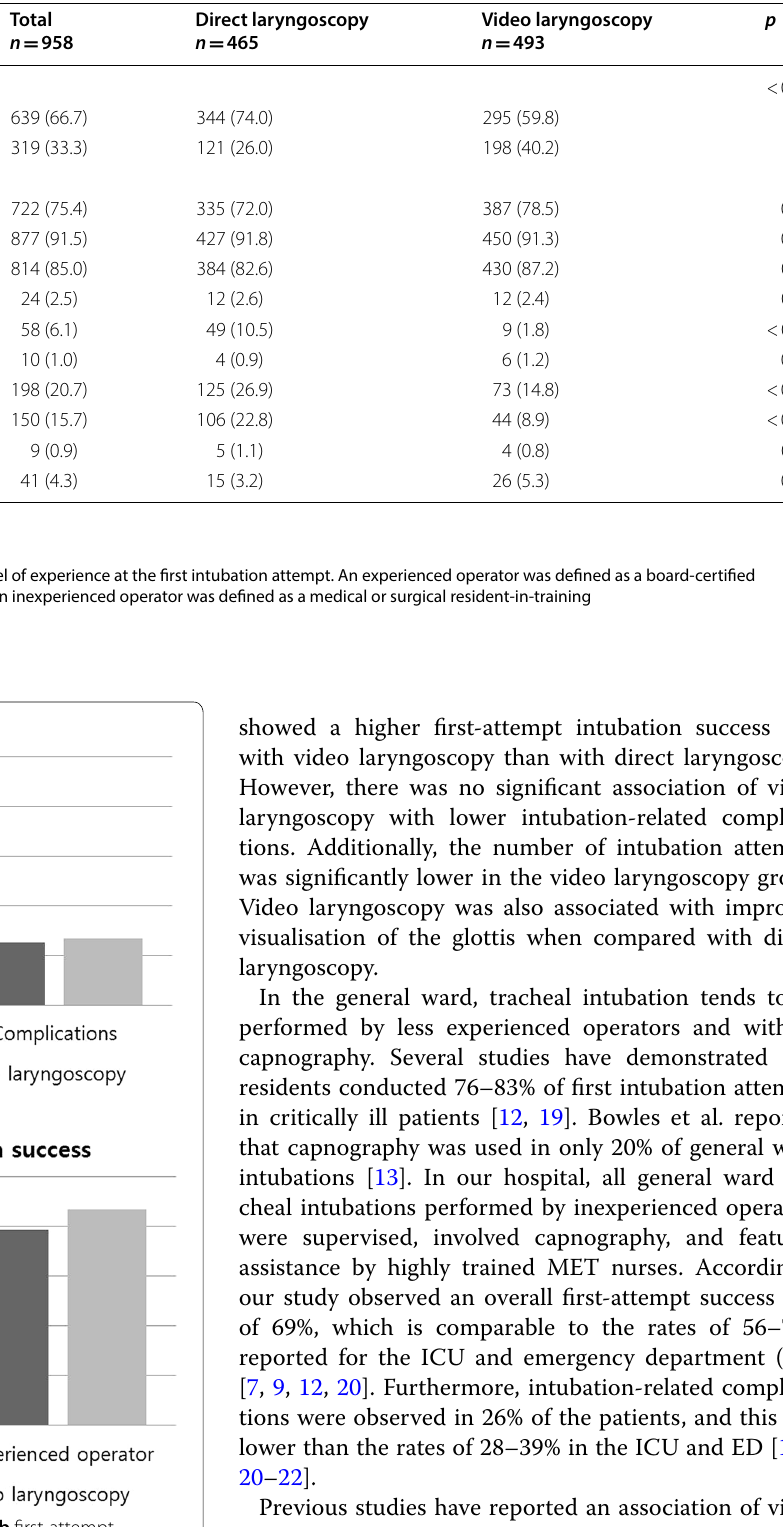
Fig. 2 Main results of the study. a Outcomes, b